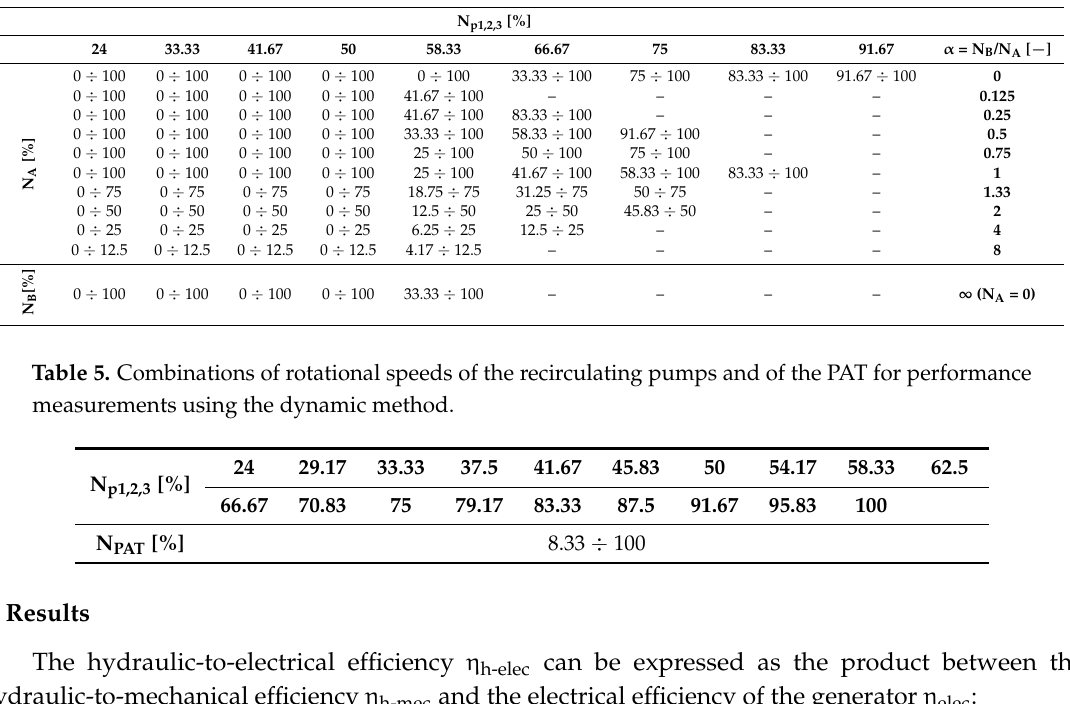
Table 4. Microturbine runners rotational speed variation ranges for performance measurements using the dynamic method.